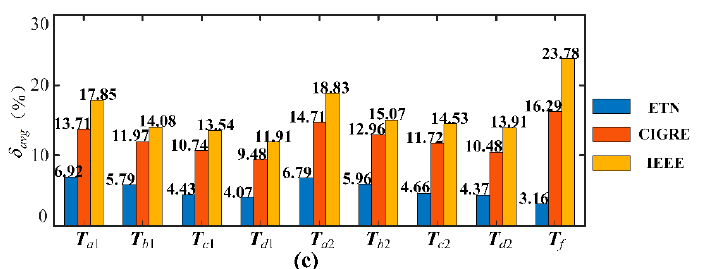
Figure 7. Verification of temperature calculation methods based on ETN. ( a ) Comparison of temperature rise test and calculation results; ( b ) Absolute relative error δ e in different zones of the conductor cross-section; ( c ) Comparison of average absolute relative error δ avg between non-linear iterations and standard calculations.